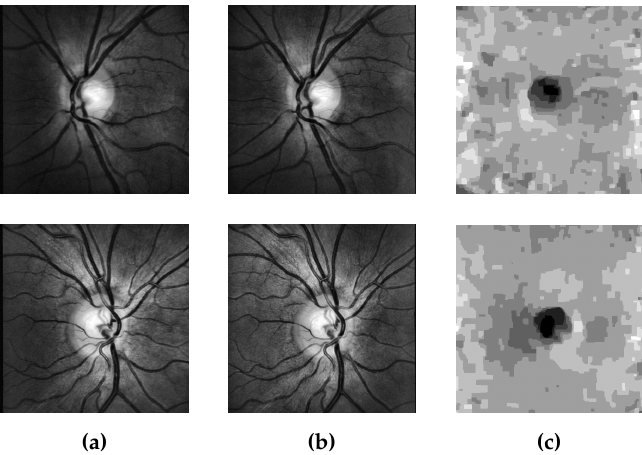
Figure 7. Retina Optic Nerve Head (ONH) depth approximation by use of stereo image pairs: ( a ) left view; ( b ) right view; ( c ) approximated depth map. The darker the region, the greater the